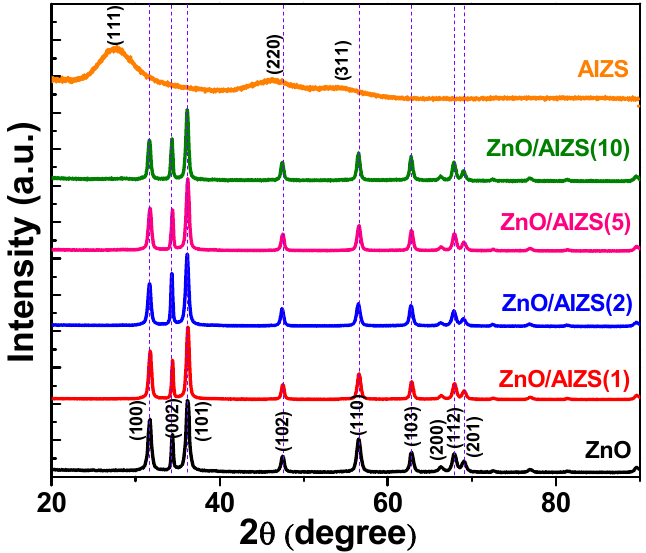
Figure 3. XRD patterns of AIZS QDs, ZnO NRs and ZnO/AIZS heterostructured photocatalysts.